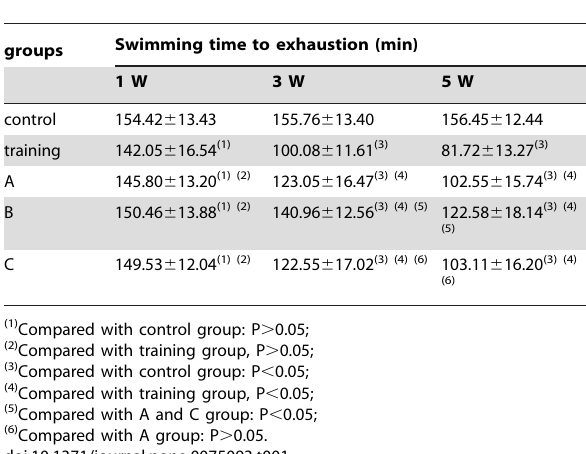
Table 1. Effect of pulse current on swimming time to exhaustion of